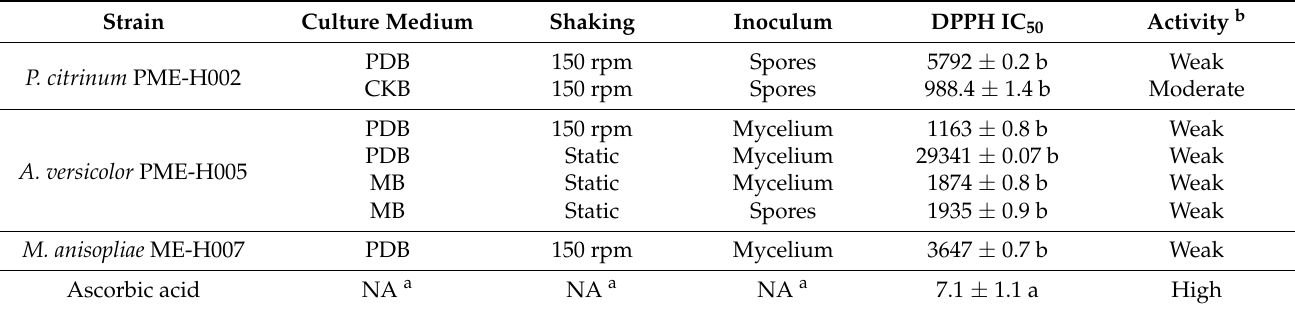
Table 3. IC 50 ( µ g/mL) of antioxidant activity of endophytic fungi methanol extracts with anti- cancer